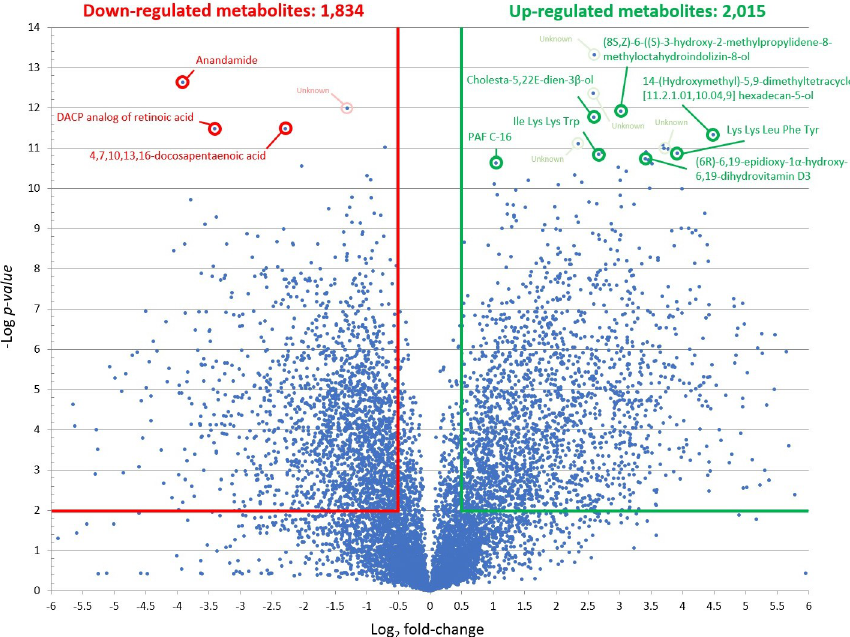
Fig 2. Volcano plots showing differentially expressed metabolites of S . mekongi following low-dose PZQ treatment. Horizontal green and red lines represent p- values equal to 0.01. Vertical green and red lines represent fold changes equal to 1.5 and − 1.5, respectively. Top 10 metabolites with the lowest p -values (highly significant) and largest fold changes of each dose were labeled. Green and red refer to higher and lower abundance of metabolites, respectively.